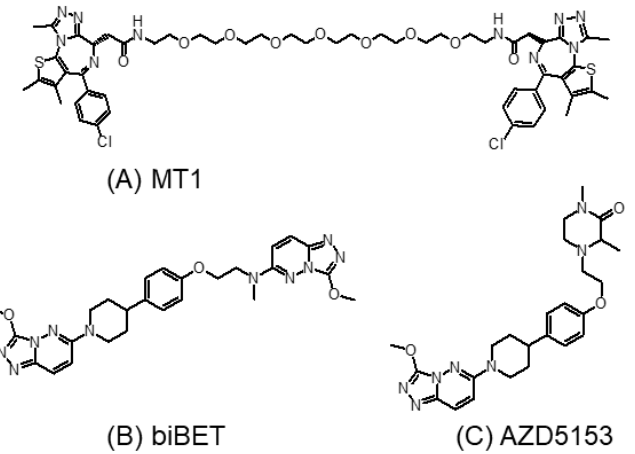
Figure 6. Chemical structures of the bivalent BET inhibitors discussed: ( A ) MT1, ( B ) biBET, and ( C ) AZD5153.